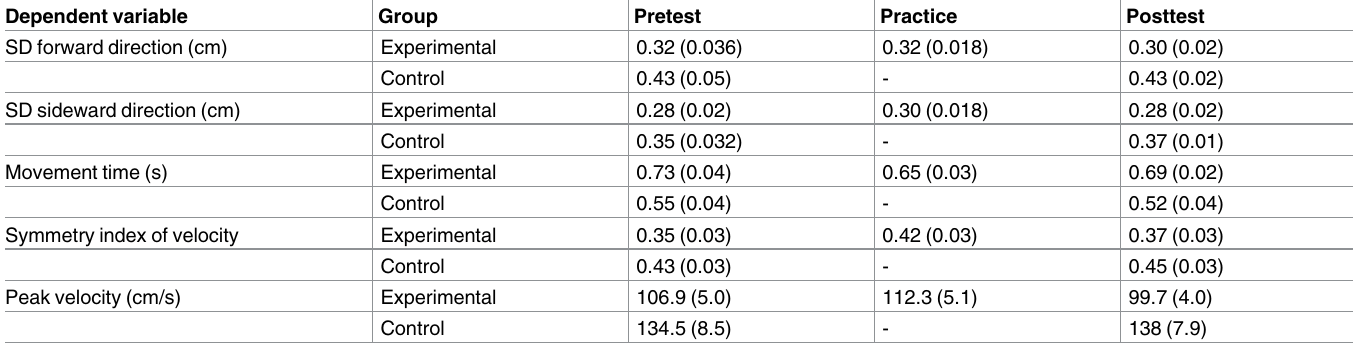
Table 1. End-effector kinematics per condition and group.